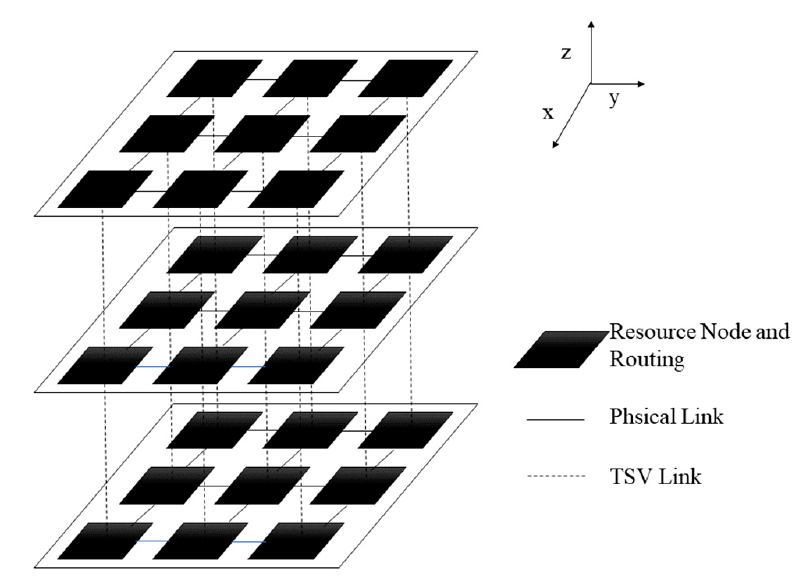
Figure 1. 3D NoC architecture graph.